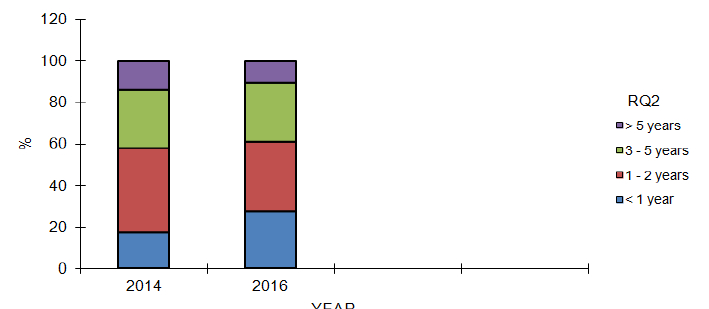
Fig. 4 – Bar chart of relative shares (RQ2) (source: